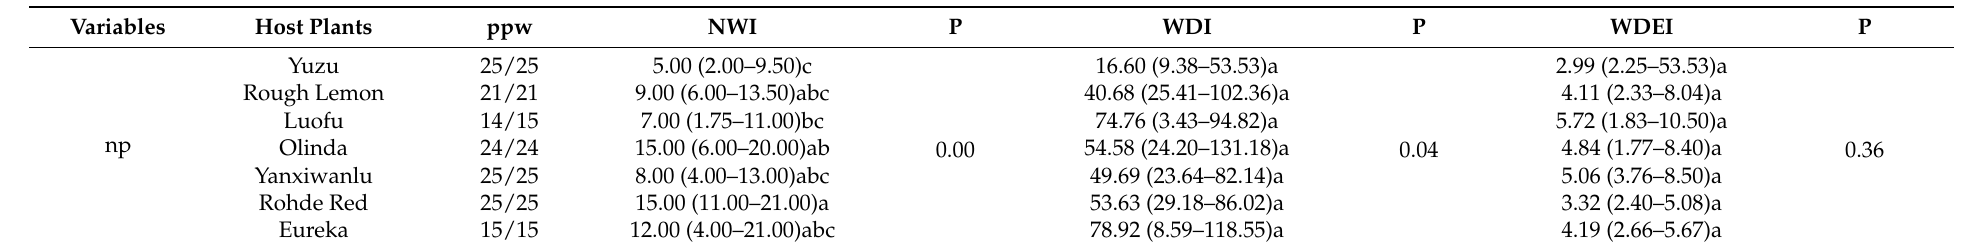
Table 3. Nonsequential EPG variable values for T. citricida probing behavior on seven host plants during a six-hour